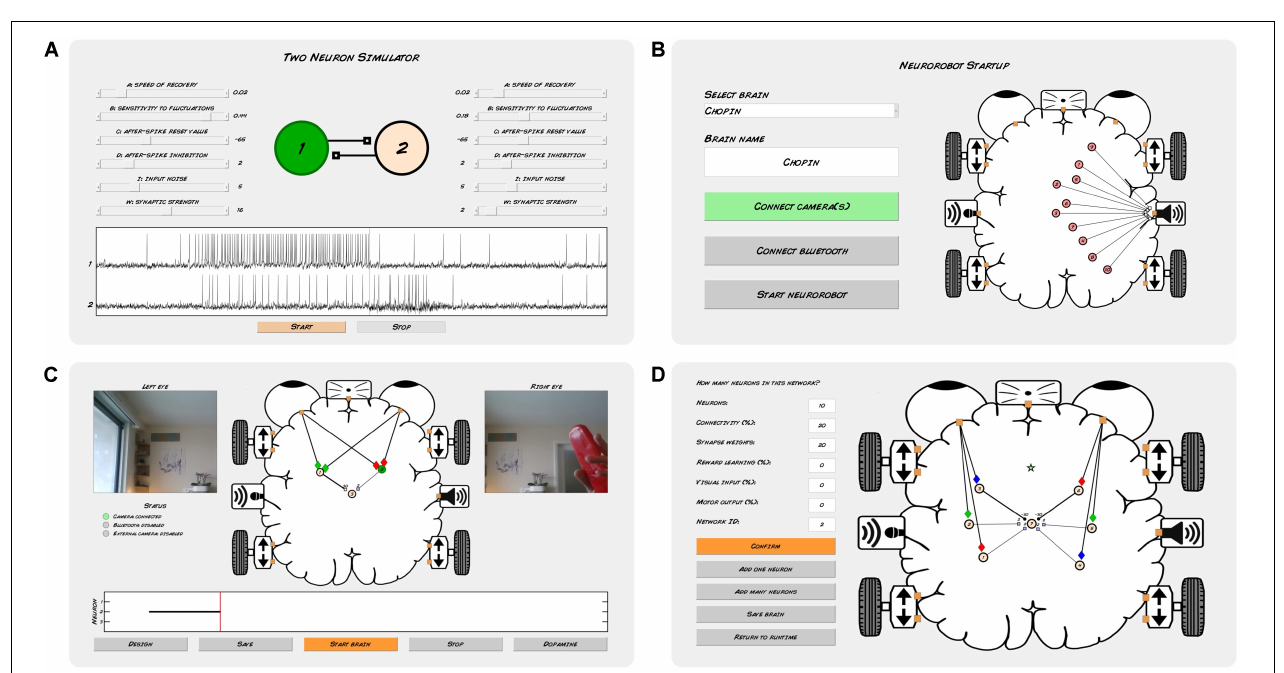
FIGURE 1 | A DIY neurorobot for education. (A,B) Top and sideways views showing the neurorobot’s chassis, battery, controller (with motor shield on top), WiFi camera module, speaker, distance sensor, Bluetooth modem and sunglasses. (C) Schematic showing the flow of signals in the system.